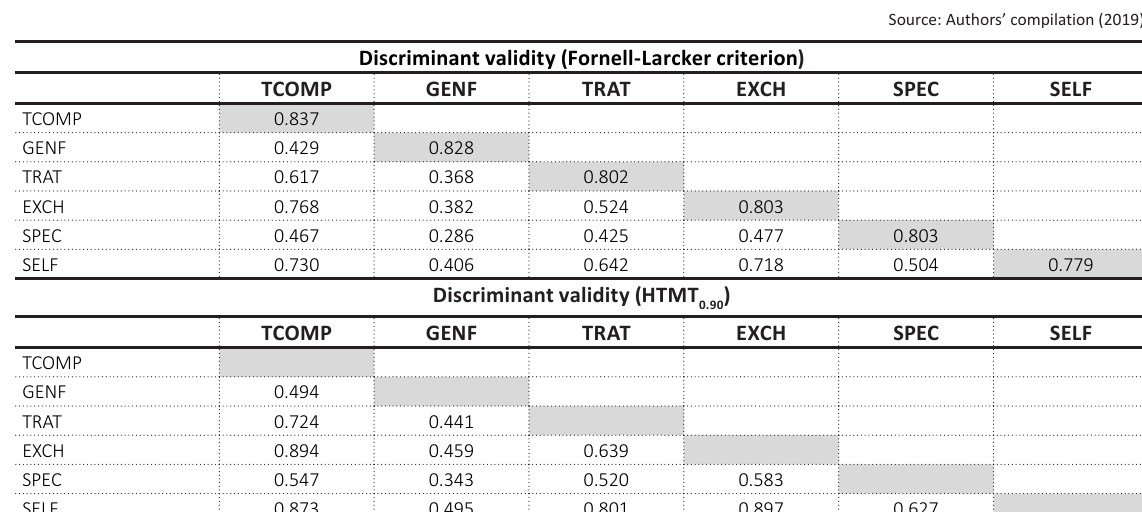
Table 2. Discriminant validity